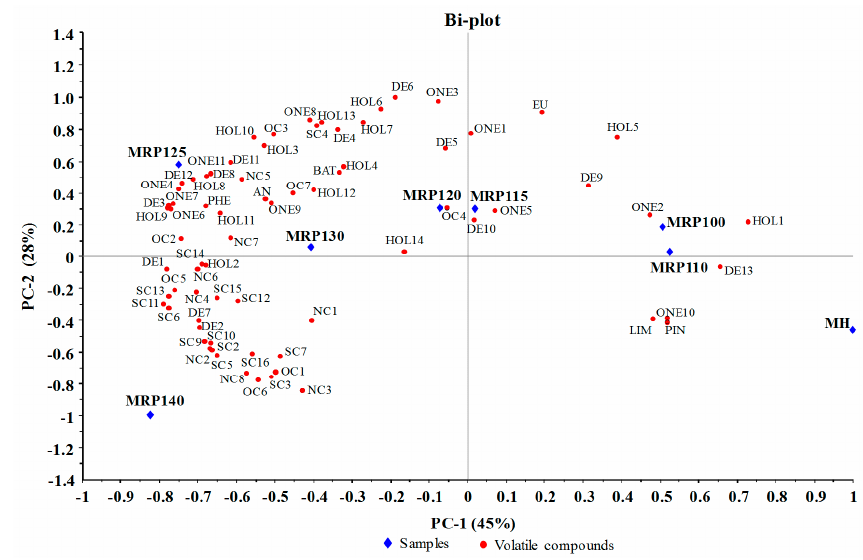
Figure 1. Bi-plot of volatile compounds and samples.